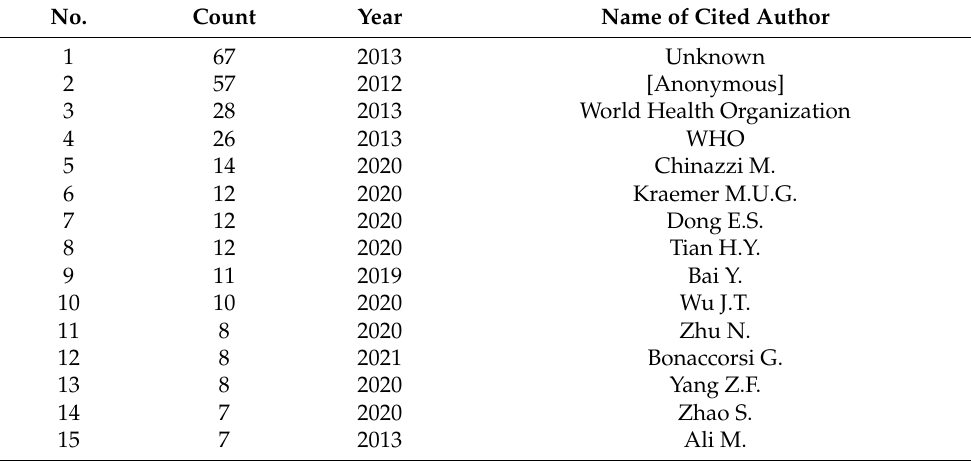
Table 8. Top 15 most cited authors of studies of epidemic control based on big data research, extracted through CS analysis.